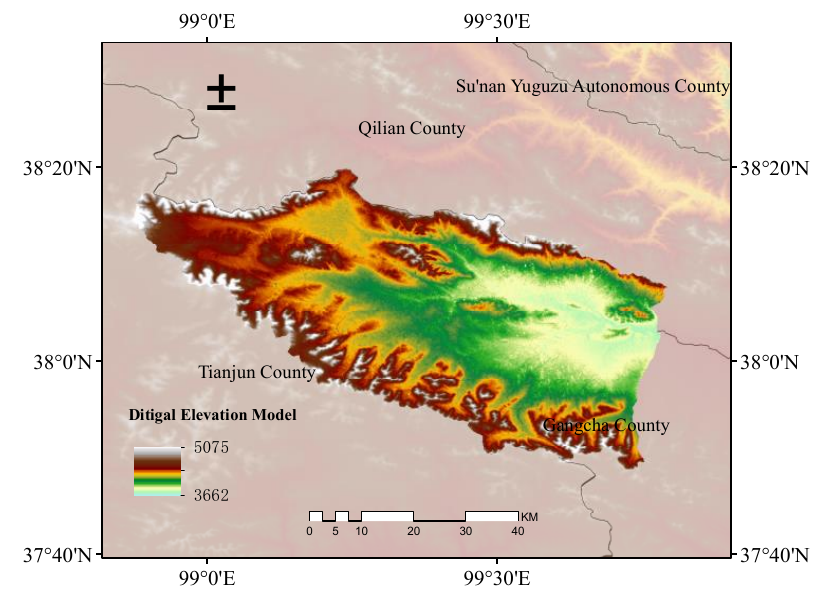
Figure 1. Digital elevation model (DEM) image map of the Muli region.